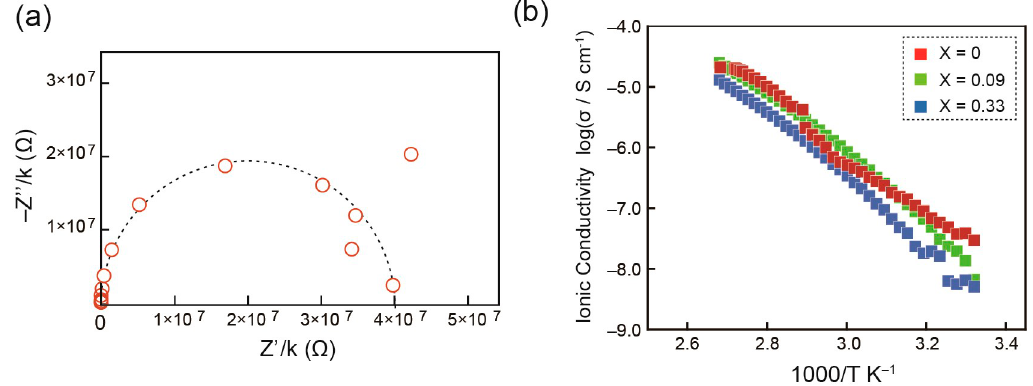
Figure 6. ( a ) A Cole–Cole plot for compound 1 at 36 °C in the Cub bi phase. ( b ) Arrhenius plots of ionic conductivities of compound 1 and the 1 /LiBF 4 mixtures (X = 0.09 and